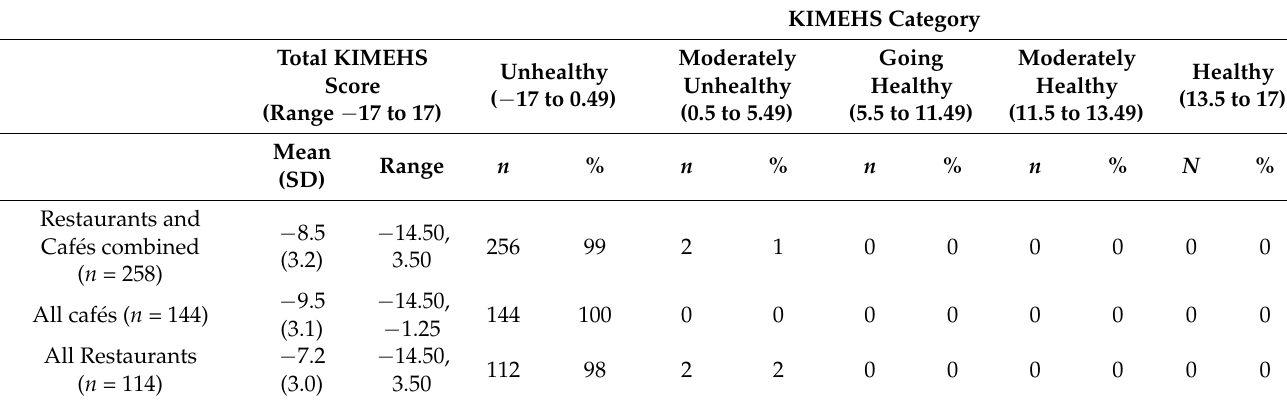
Table 4. Kids’ Menu Healthy Score (KIMEHS) results.